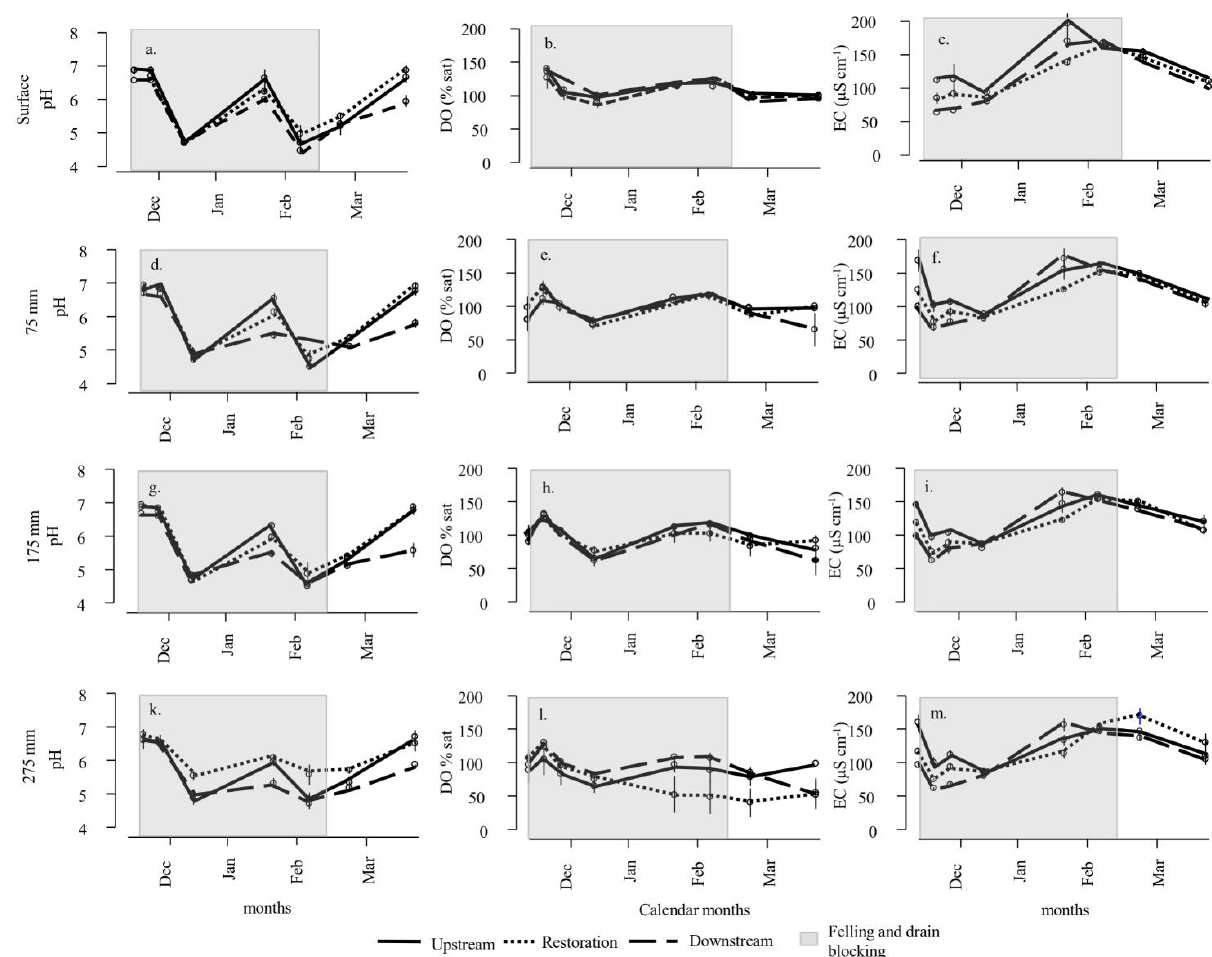
Figure 2. Temporal trends for pH, dissolved oxygen (DO) and electrical conductivity (EC) in water samples collected at the surface (a–c) and at depths of 75 mm (d–f), 175mm (g–i) and 275 mm (k–m) in the River Dyke at sites upstream of (black line), within (dotted line) and downstream of the forest undergoing restoration work (dashed line) between November 2014 and March 2015. Shaded areas indicate the period of active management (tree felling and drain